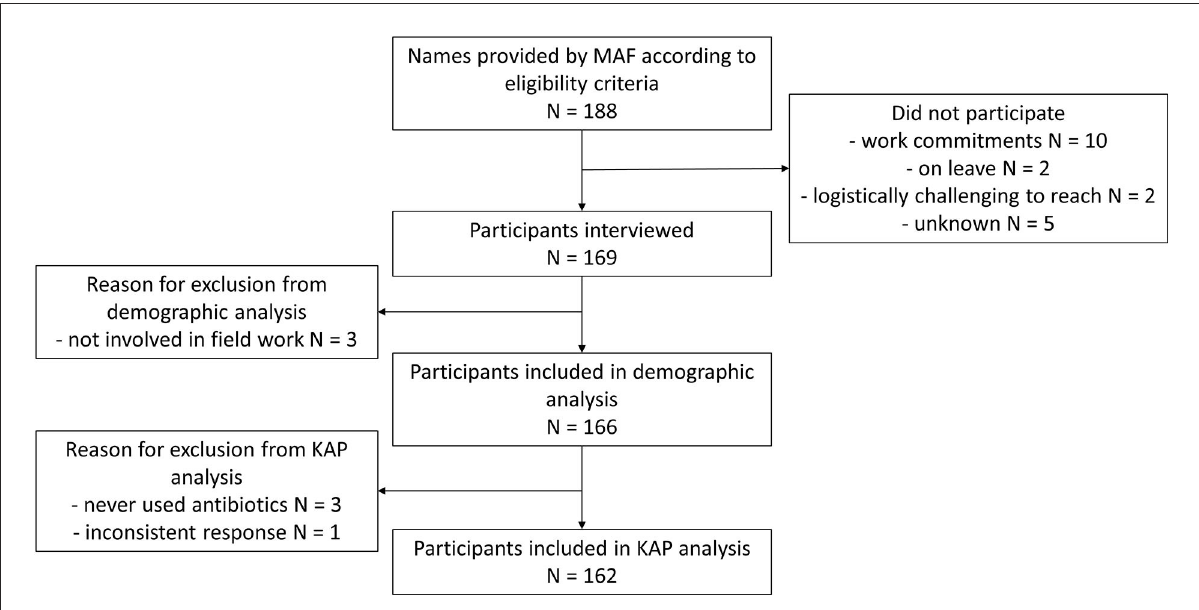
FIGURE1 Study flowchart providing reasons for non-participation and exclusion from